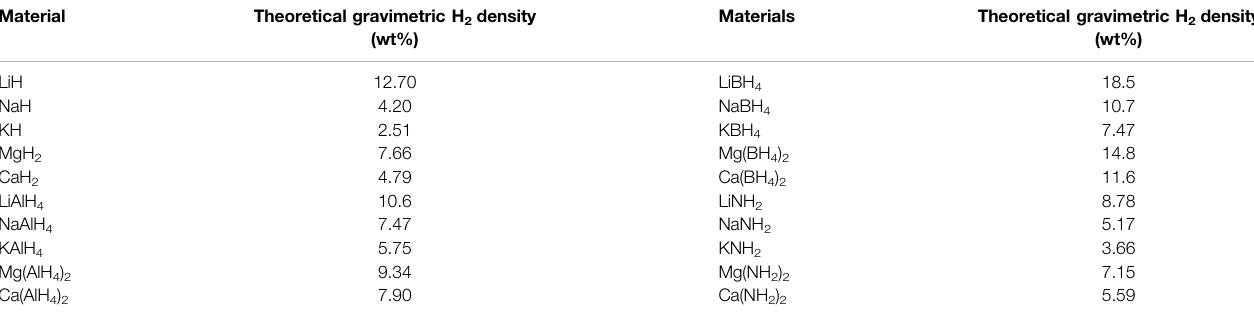
TABLE 1 | Hydride materials and theoretical gravimetric hydrogen density (Kojima, 2019).